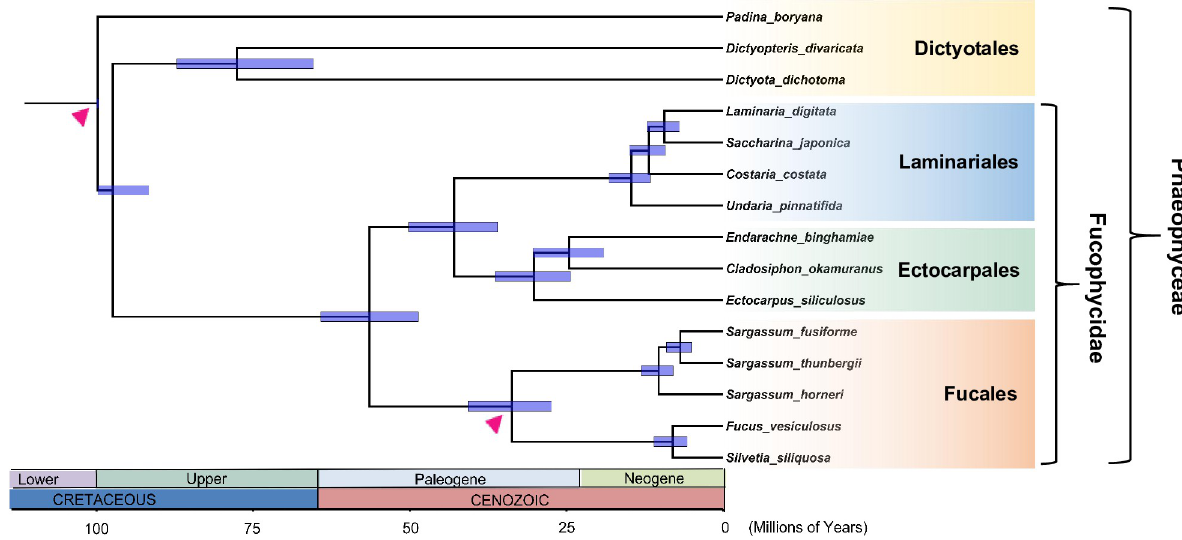
Fig 3. Posterior estimates of divergence time of 15 taxa on the phylogenetic tree. Blue bars depict the 95% highest posterior density (HPD) and the values at the nodes represent posterior mean ages. Estimations were performed with MCMCTree based on the independent rate model using two fossil calibrations on nodes indicated by